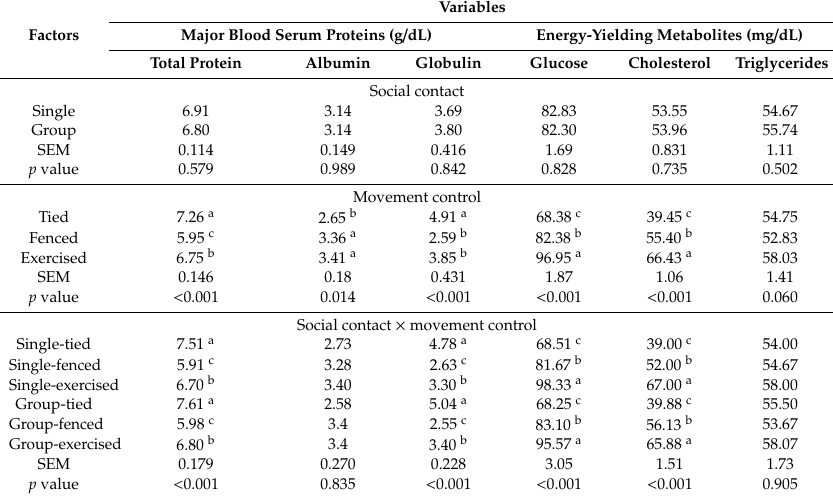
Table 4. E ff ects of social contact, movement control and their interaction on concentrations of blood serum major proteins and energy-yielding metabolites of male dromedaries during the rutting season.